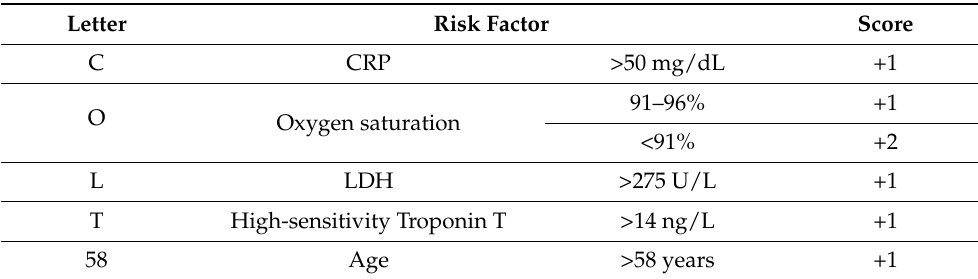
Figure 2. Forest plots for HR of clinical parameters for ICU admission and death at 30 days in COVID-19, overall controls, and respiratory controls. X-axis shows HR in logarithmic scaling. Higher HR suggests higher association with poor outcome; COVID-19 = coronavirus disease 2019, CKD = chronic kidney disease, hs-cTnT = high-sensitivity troponin T, CRP = c-reactive protein, LDH = lactate dehydrogenase, HR = hazard ratio, ICU = intensive care unit, CI = confidence interval. Table 5.